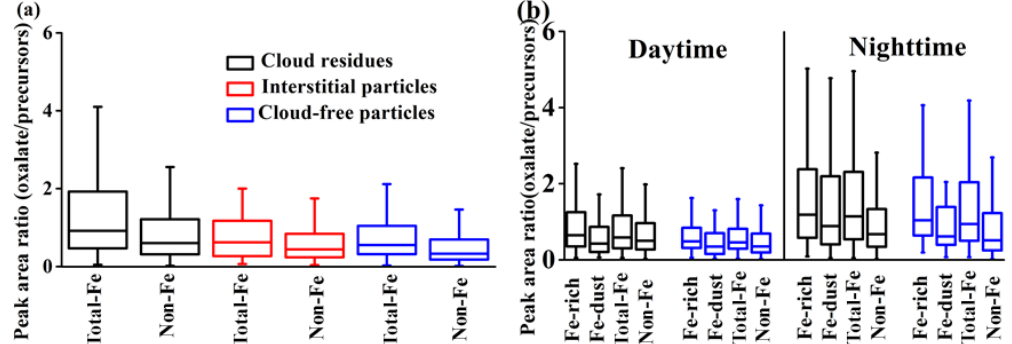
Figure 5. Peak area ratio of oxalate ( m/z − 89) to the sum of the peak areas of its precursors ( m/z − 59, − 71, − 73, − 87, − 103, or − 117) in the total-Fe and non-Fe types (a) . Peak area ratio of oxalate to its precursors in the Fe-rich, Fe-dust, total-Fe, and non-Fe types during daytime and nighttime (b) .